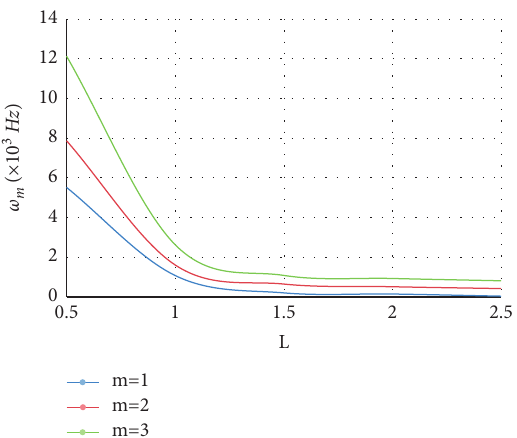
Figure 4: Relation between frequency and length of four-layered shells 0 0 /90 0 /0 0 /90 0 ( GE / KE / GE / KE ) ; n � 2.